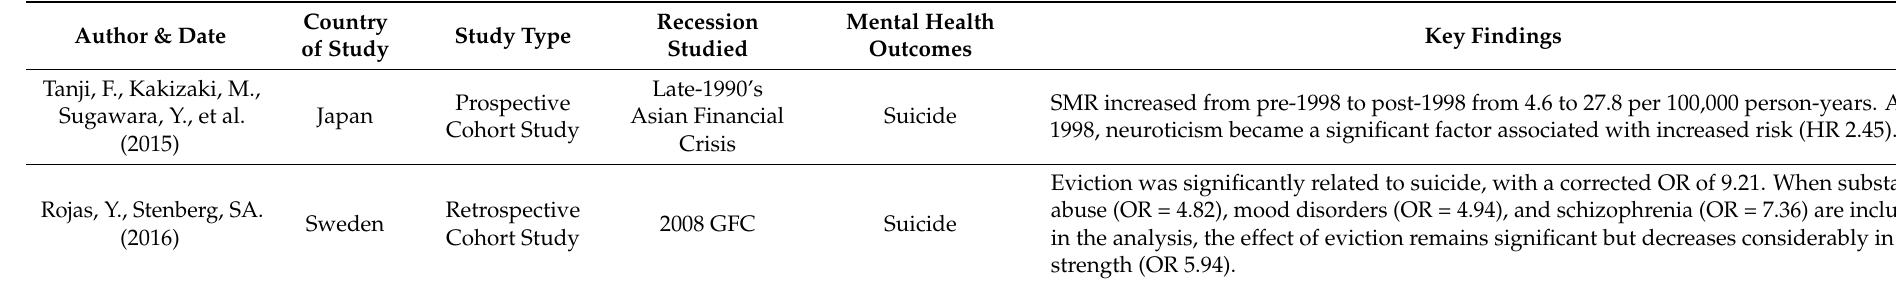
Table 4. Summary of included articles on suicide (N =